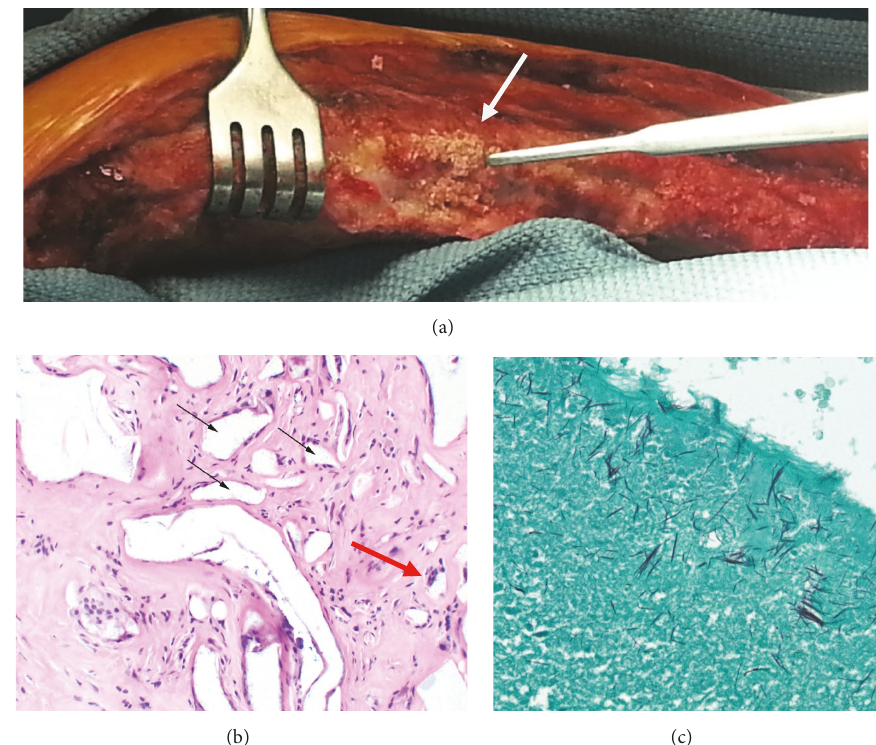
Figure 2: An intraoperative image demonstrating the appearance of Kryptonite (arrow) as it is peeled away from the cut-edge of the sternum after sternotomy (a). Hematoxylin and eosin staining demonstrating Kryptonite (clear granular filled “spaces” within the fibroconnective tissue; black arrows) and foreign body type giant cells (red arrow; 20x) (b). Grocott silver staining highlighting the fibrillary structure of Kryptonite (10x)